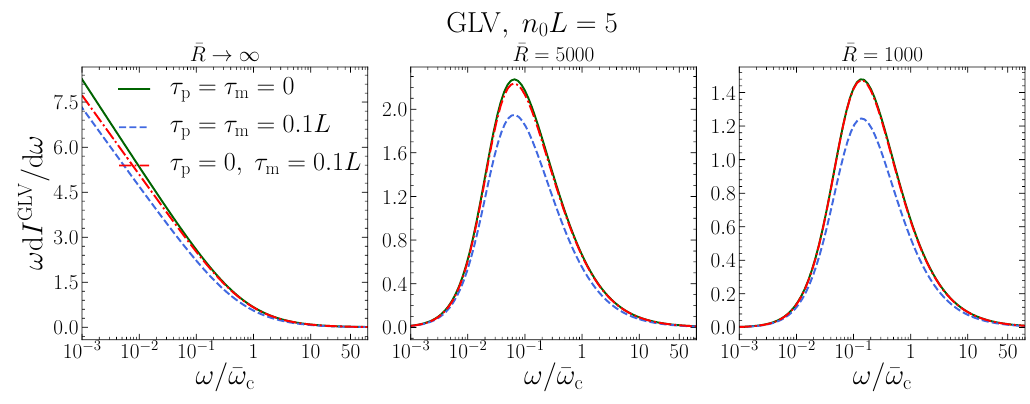
Figure 4 . GLV medium-induced energy spectrum for τ p = τ m = 0 (green solid lines); τ p = τ m = 0 . 1 L (blue dashed lines); and τ p = 0 and τ m = 0 . 1 L (red dash-dotted lines) as function of ω/ ¯ ω c for n 0 L = 5 . The different panels correspond to different sets of ¯ R : ¯ R → ∞ (left), ¯ R = 5000 (central), and ¯ R = 1000